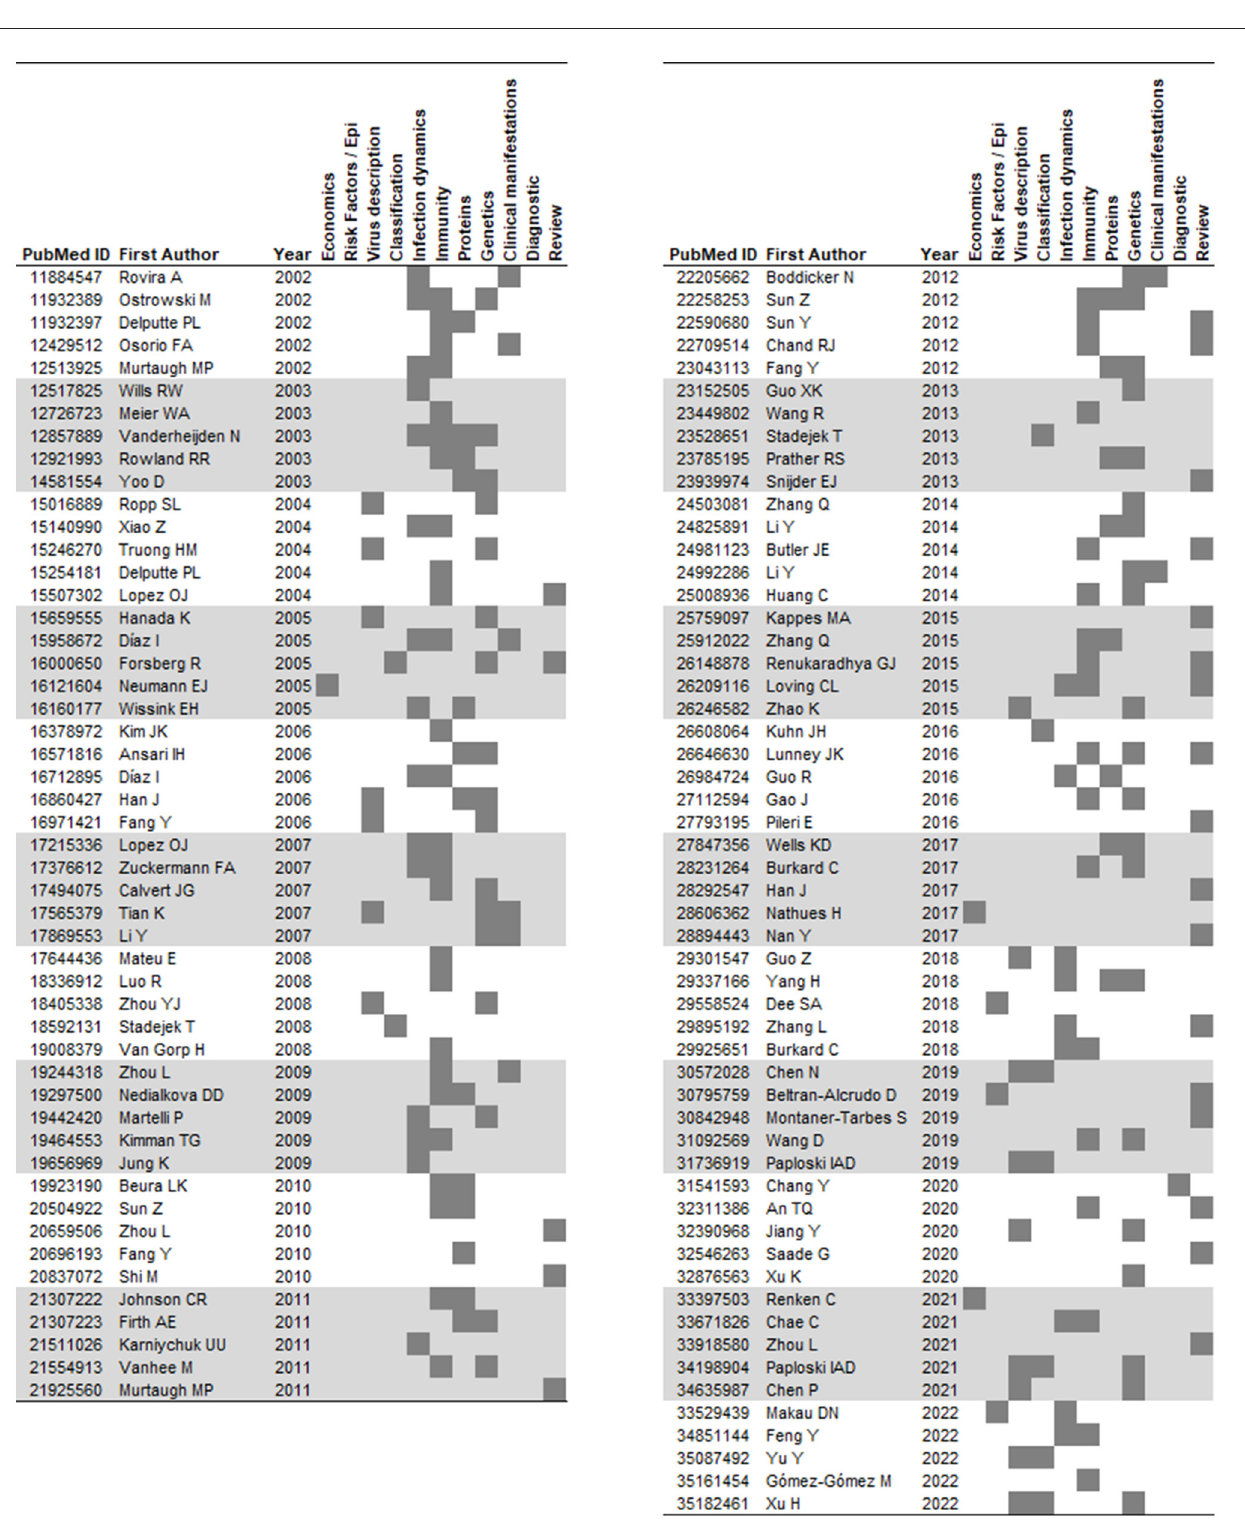
FIGURE1 List of top-five most cited papers per year (2002–2022) according to the topic covered by the paper (gray boxes).